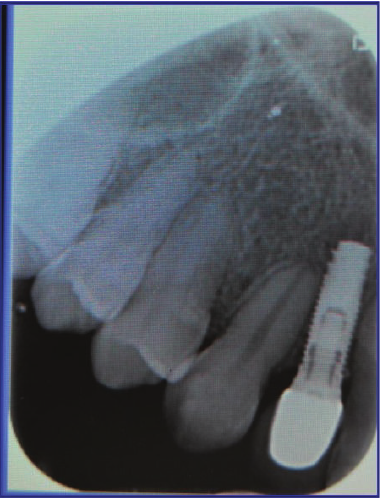
Figure 16: Radiographic control after one year in site to the left.